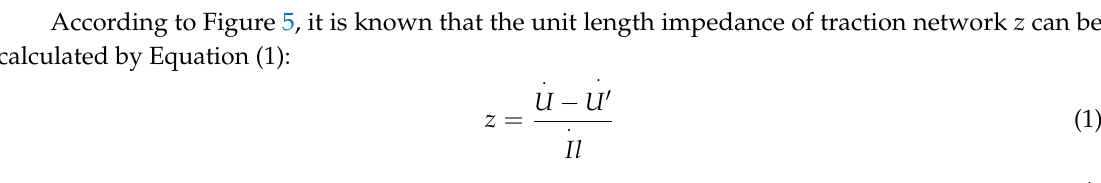
Figure 5. The original circuit model of the traction network.